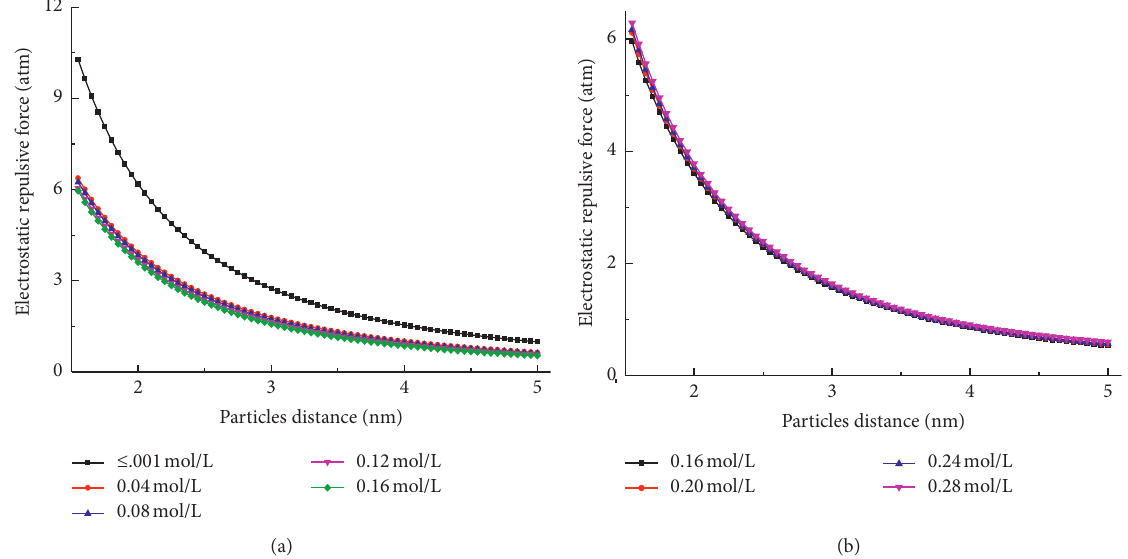
Figure 4: Relationship between electrostatic repulsive force and distance between two particles. (a) ≤ 001 ∼ 0.16mol/L (NH